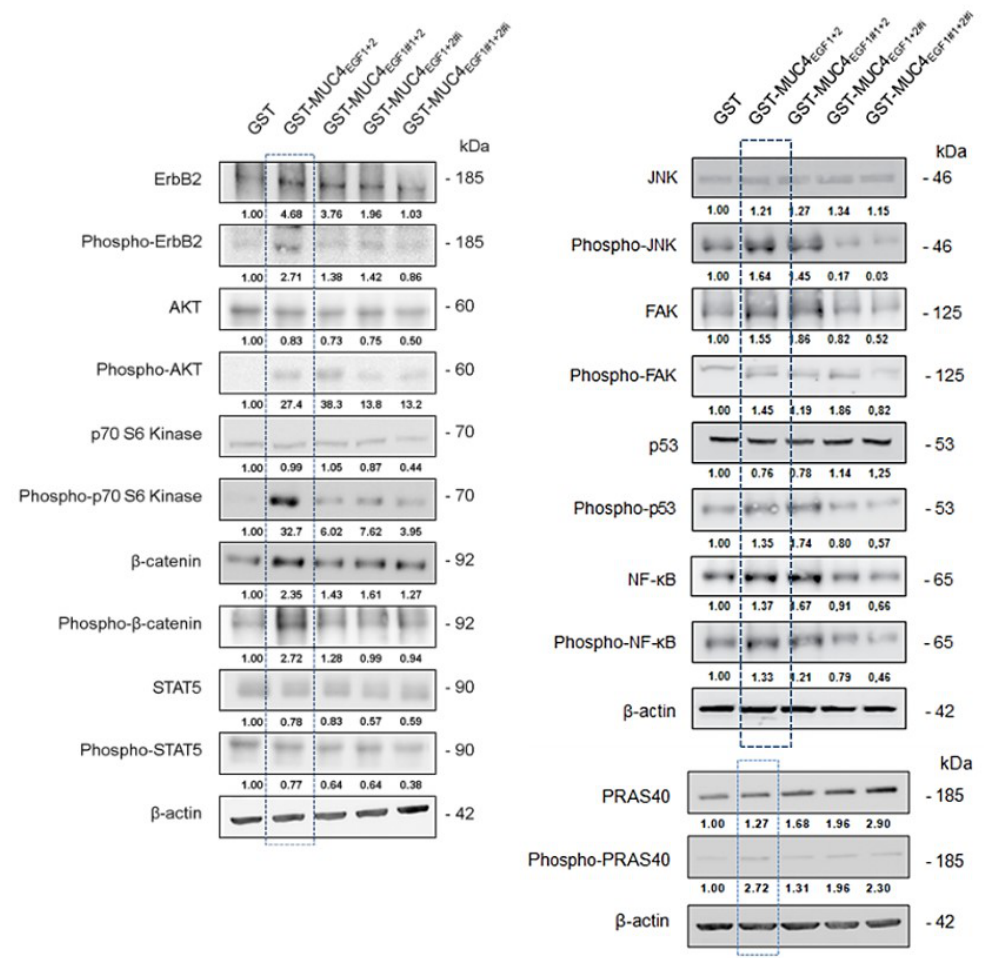
Figure 6. Effects of GST-MUC4 EGF1+2 and their mutants on intracellular signaling pathway activity. Expression and activation (phosphorylation) of signaling proteins of interest (those activated in phos- phokinase arrays, see Figure S12), by Western blotting, in Panc-1 cells treated with GST-MUC4 EGF1+2